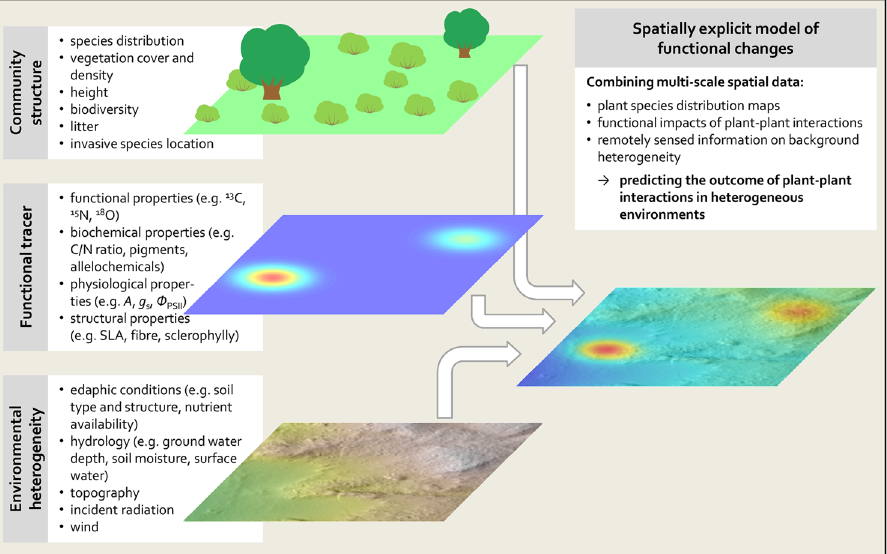
Figure 1. Schematic illustrating how different layers of spatial information can be combined into one joint model to yield spatially explicit predictions of functional tracers. Potential predictors can include the distribution of key species (e.g. presence of an invasive plant species), structural information, or raster maps of abiotic environmental conditions. Data can be derived from field measurements or from remote sensing products. The functional tracer can, for example, be measured in the vegetation or in the soil and should be suitable for spatially explicit data acquisition. A – rate of photosynthetic carbon assimilation; g s – stomatal conductance; Φ PSII – maximum quantum efficiency of photosystem II; SLA – specific leaf